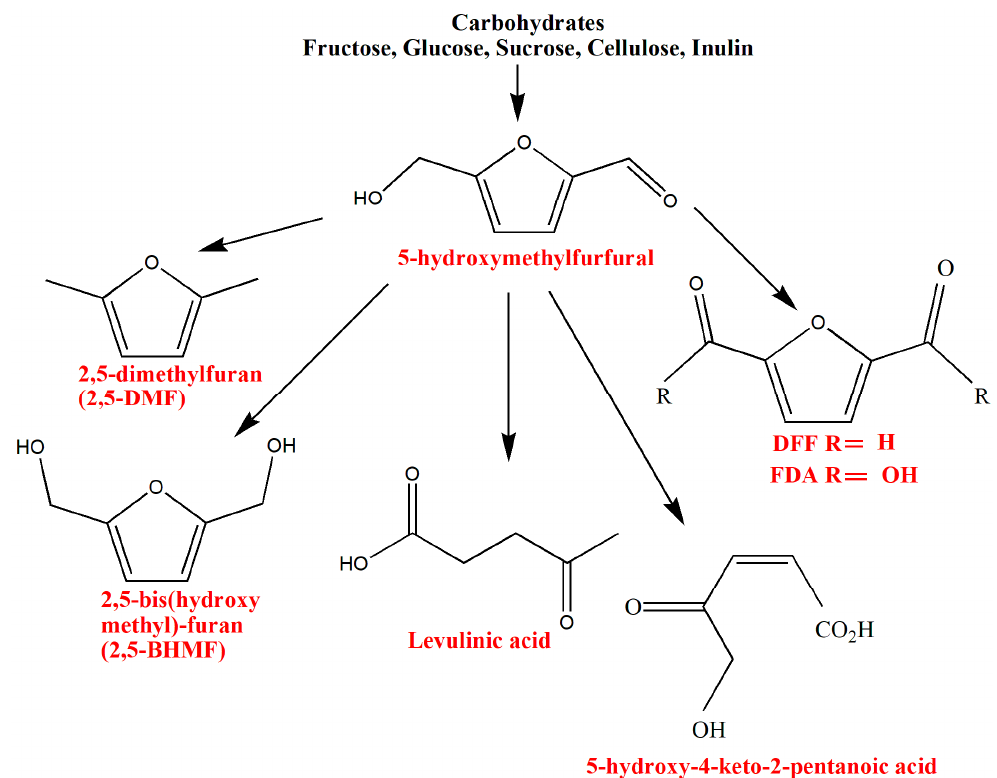
Figure 6. Hydroxymethylfurfural and its derivatives [DFF: 2,5-diformylfuran and FDA: 2,5-furan dicarboxylic acid] [15].